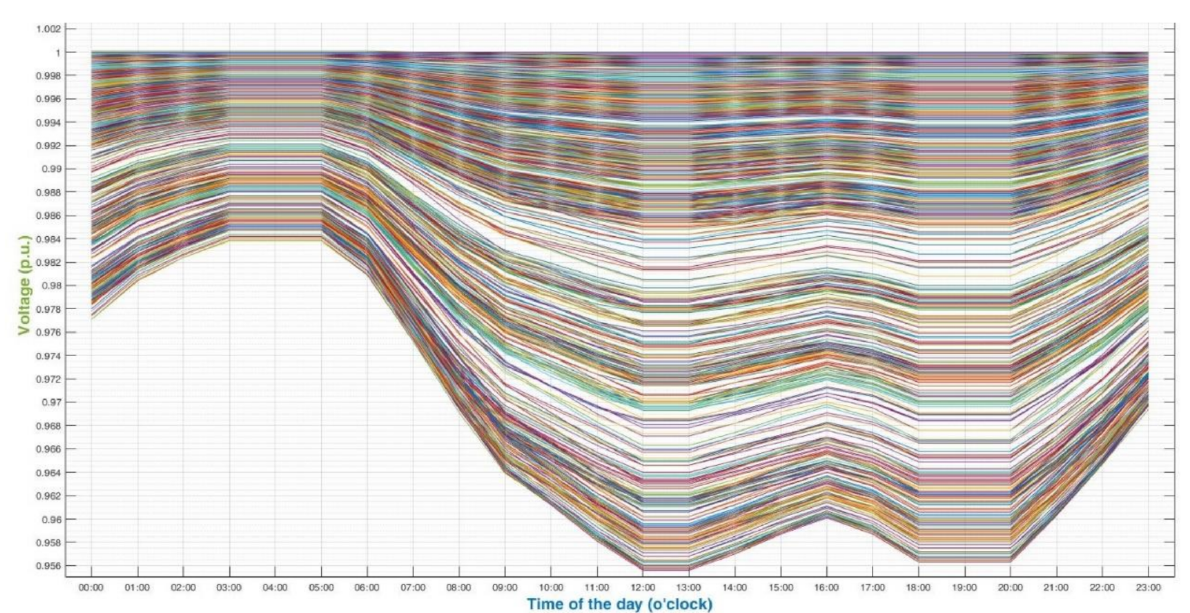
Figure 10. Voltage magnitude per unit of the buses for the LV and MV levels.